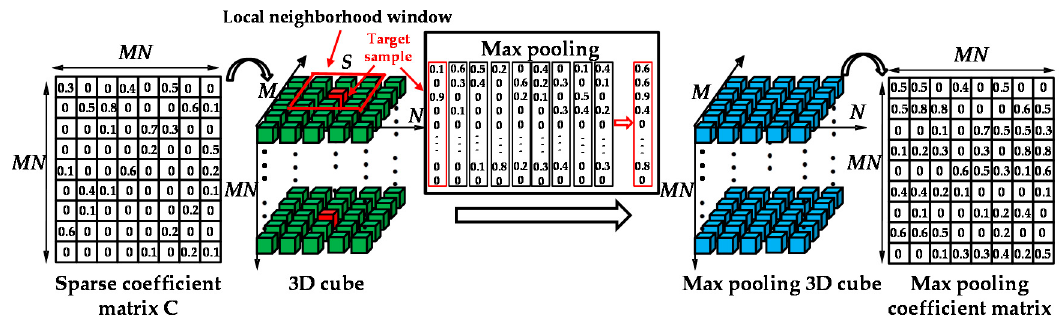
Figure 1. Graphical illustration of the process of spatial max pooling. Firstly, the 2-D sparse coefficient matrix is reshaped into a 3-D cube along rows. Then, a local neighborhood window of size S is considered for each representation coefficient vector, with the currently processed one as the center. Following this, the max pooling operation is performed on the local neighborhood window to select the local, largest coefficient value of each band to act as one element of the newly generated coefficient vector for the target pixel. Lastly, with the obtained max pooling 3-D cube reshaped into a 2-D matrix, the target max pooling coefficient matrix can be obtained.